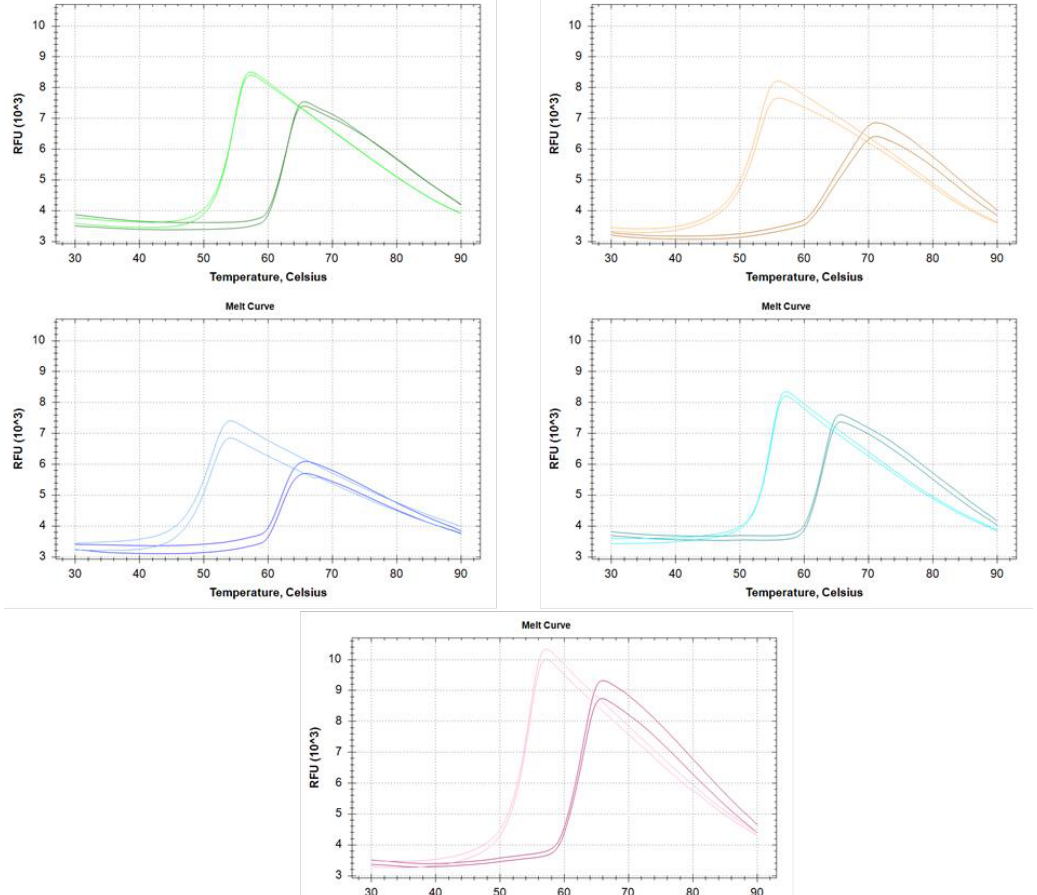
Figure 3. Melting profile of each ribonuclease inhibitor alone and in the presence of excess RNase A. Gree-Insect RI; Orange-‘RI I’; Blue-‘RI II’; Turquoise-‘RI III’; Pink-‘RI IV’. On every panel, the lighter colored curves correspond to free RI, while the darker for the RI-RNase A complex. ing temperatures of the enzymes do not directly correlate with the results derived from heat activation measurements. Without RNase A, the melting temperatures vary in the range of 50.5 – 54.6 °C, and the binding of RNase A increases the melting temperature by 8.6 – 12.4 °C to reach 62.9 – 64.1 °C. The profiles of the melting curves indicate simple two- state unfolding processes, however ’RI I’ shows a much lesser cooperative unfolding ther- mogram in complex with RNase A.